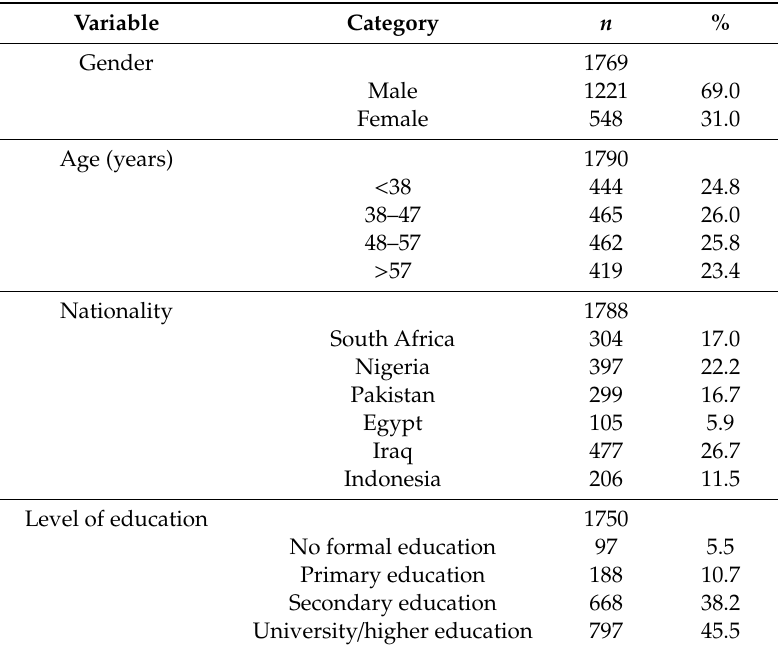
Table 1. Characteristics of the study